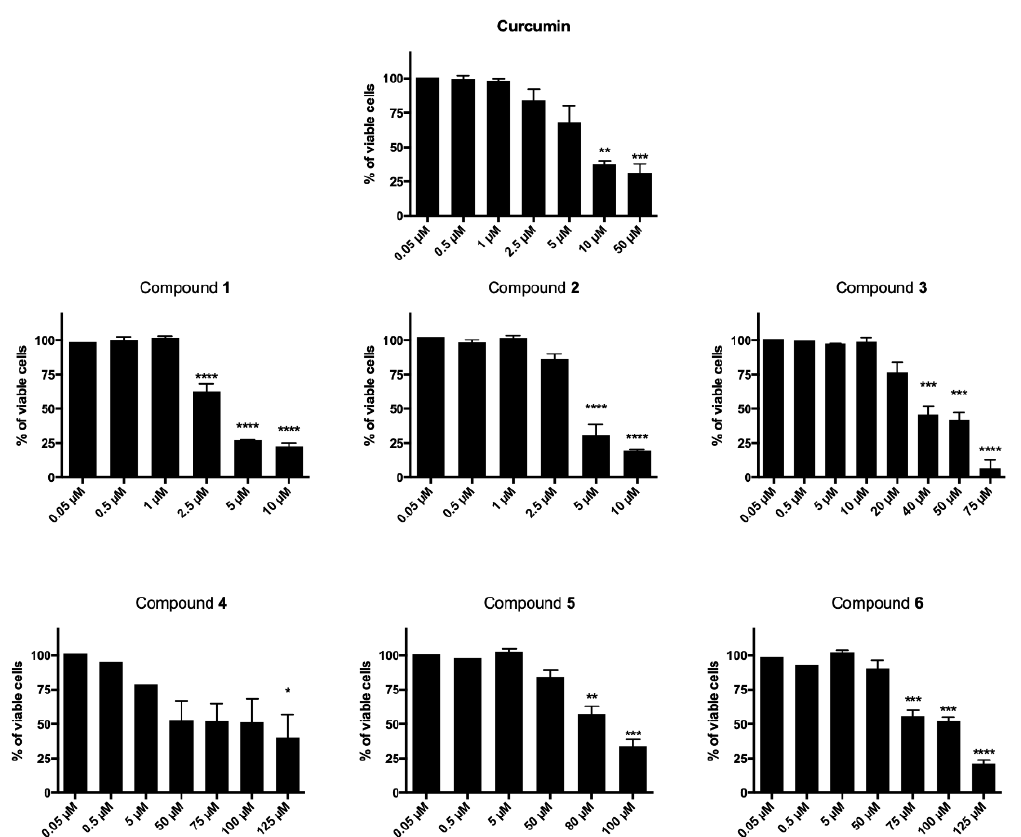
Figure 2. Cytotoxic effects normalized on untreated cells after 48 h of CCRF–CEM treatment with all derivatives and the reference compound curcumin. * p < 0.05, ** p < 0.01, *** p < 0.001, **** p < 0.0001 versus untreated cells.